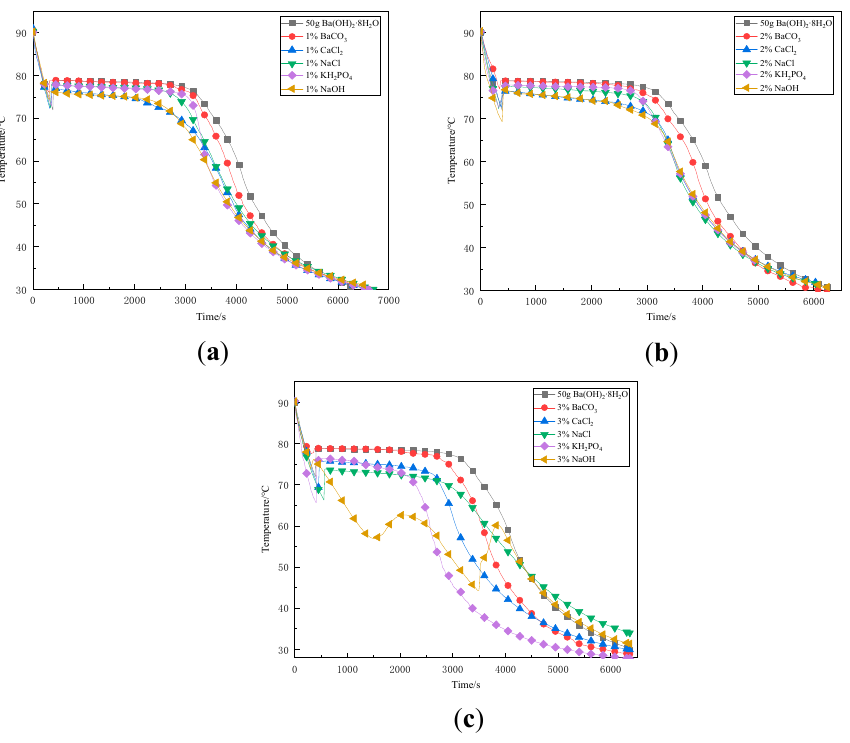
Figure 3. ( a ) The addition amount of nucleating agent is 1%; ( b ) the addition amount of nucleating agent is 2%; ( c ) the addition amount of nucleating agent is 3%.